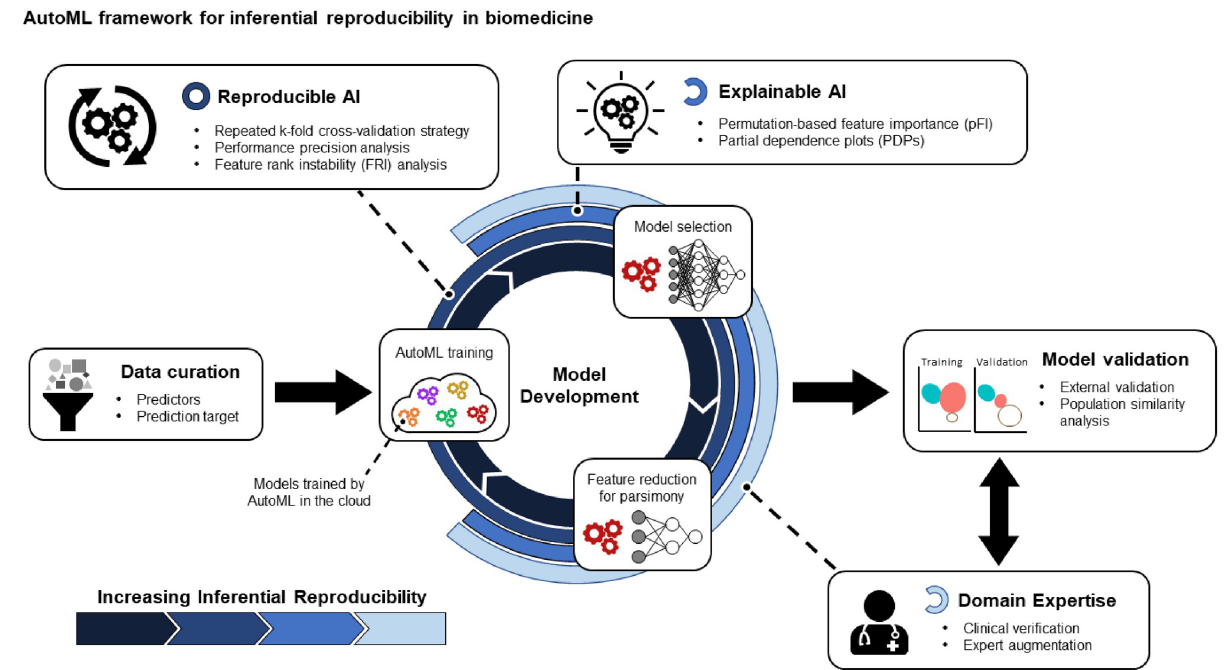
Fig 1. A framework for applying Automated Machine Learning (AutoML) for reproducible inferences in biomedical research. After data is curated, we perform a cyclical model development process utilizing AutoML to optimize an array of models. Reproducible and explainable AI tools and strategies can be applied to ultimately draw clinical and biological inferences from the models and allow for integration of domain expertise. Critically for clinical modeling, we also include a feature reduction component to achieve a more parsimonious model. The final models are then validated with external validation data along with population similarity analysis for further clinical contextualization. By applying this framework, models produced by AutoML can be stabilized and interpreted for inferential reproducibility and clinical